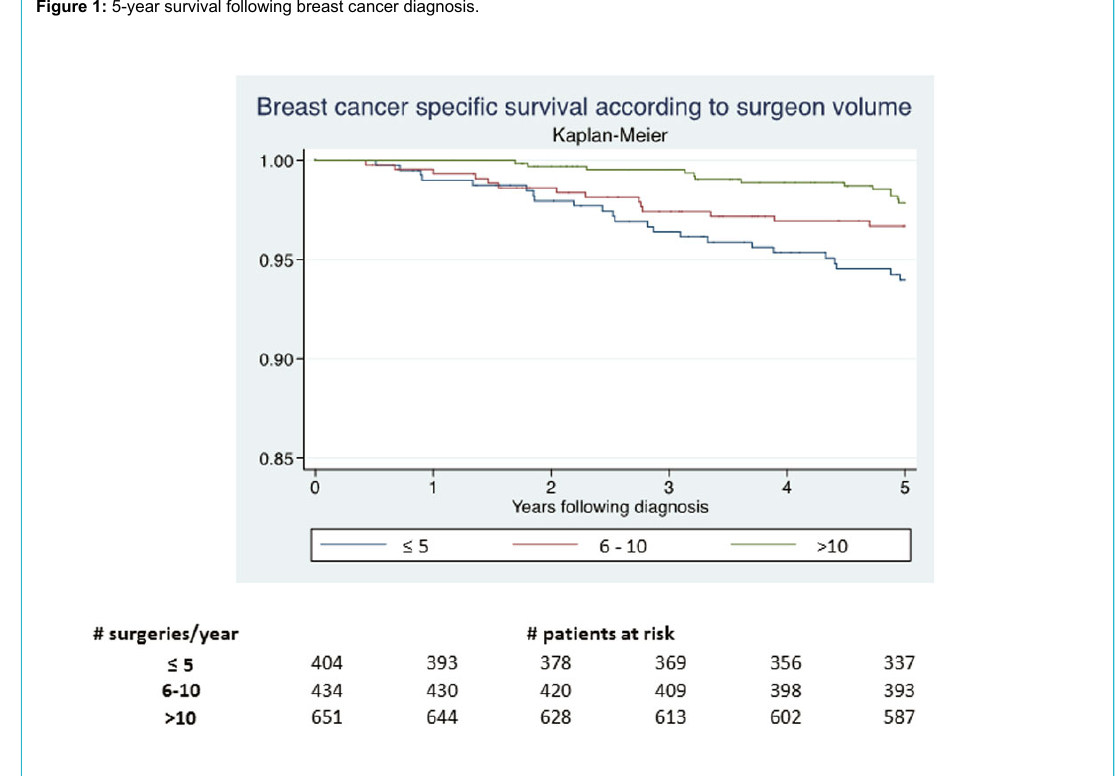
Figure 1: 5-year survival following breast cancer diagnosis.